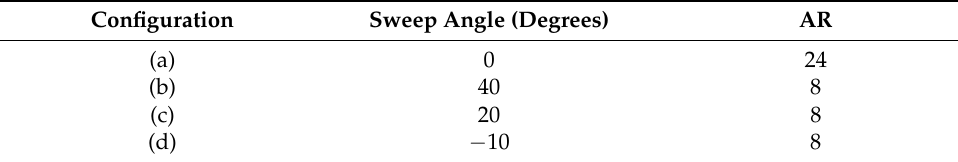
Table 5. Features of the four examined BWB configurations.